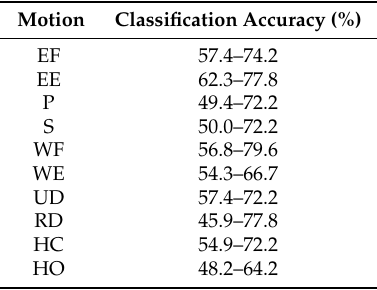
Table 3. Range of classification accuracies for each